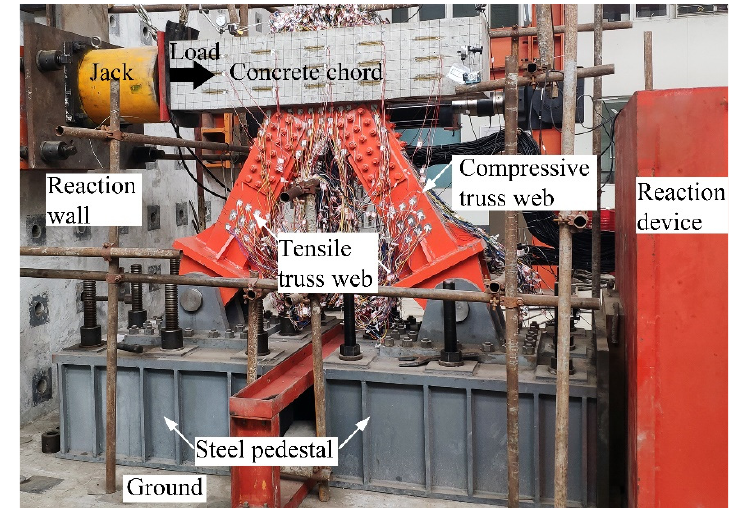
Figure 3 . Experimental setup. Figure 3. Experimental setup.